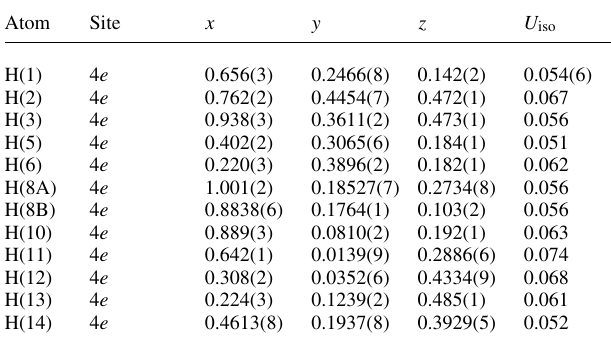
Table 2. Atomic coordinates and displacement parameters (in Å 2 )